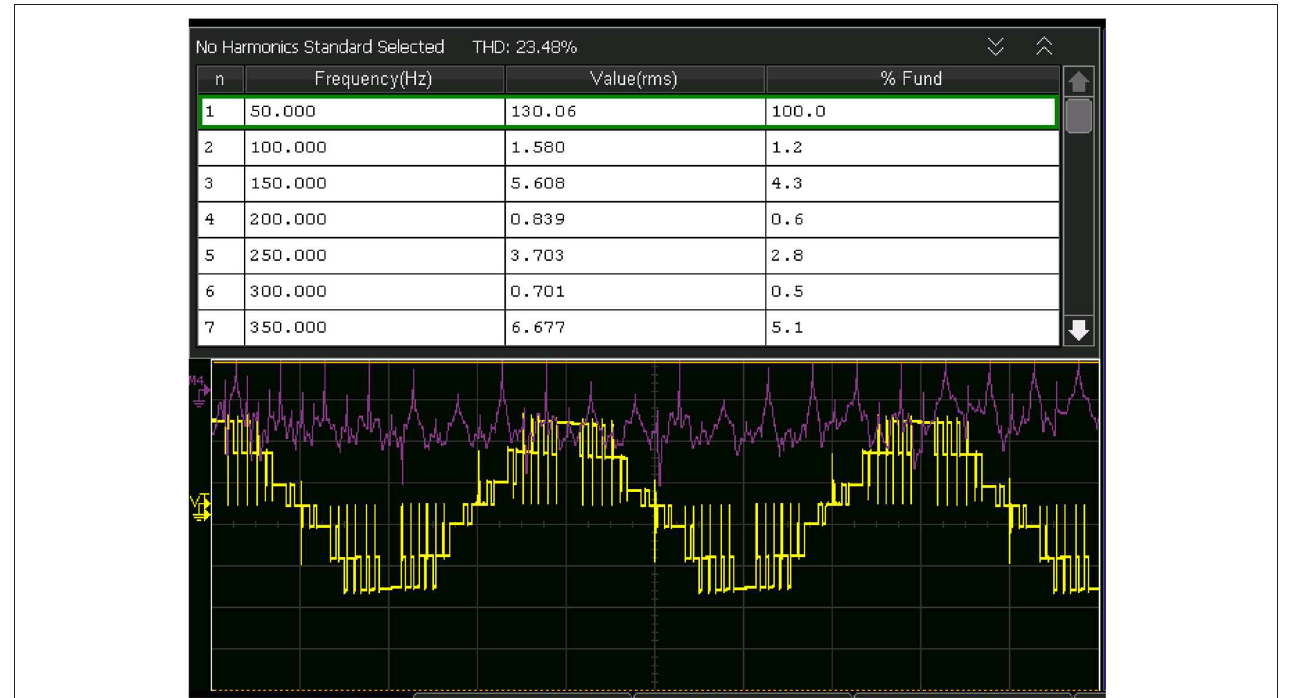
FIGURE 13 | Harmonics generated in seven-level inverter with five